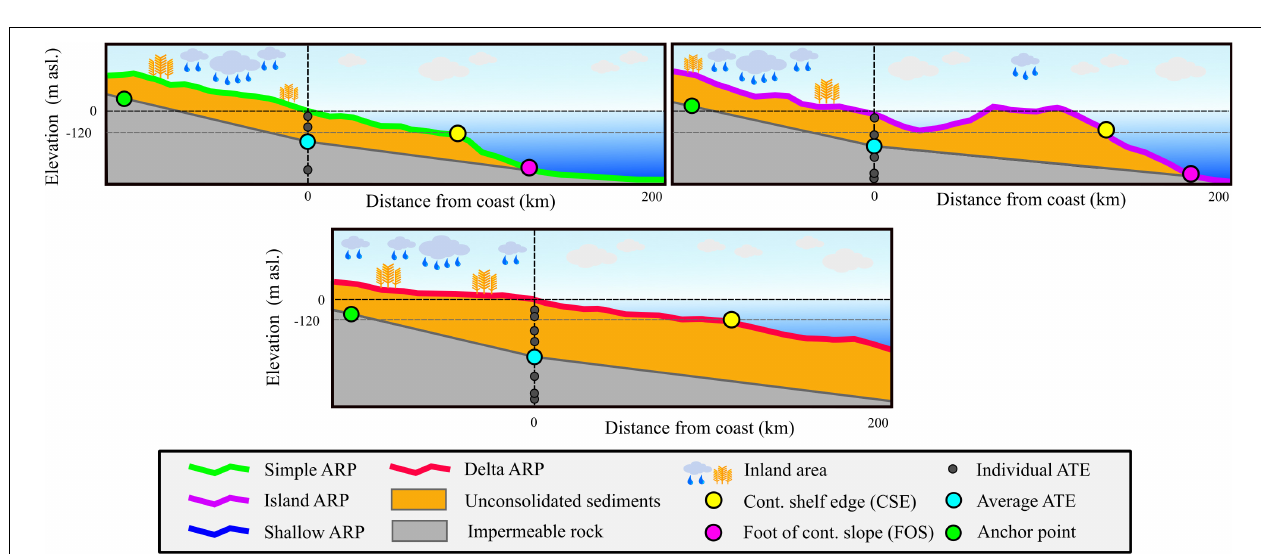
FIGURE 3 | Defining the subsurface extent of average representative profiles (ARP)s: the foot of continental slope (FOS) and the continental shelf edge (CSE) are based on Wu et al. (2017) and the average aquifer thickness estimation (ATE) is established from Zamrsky et al. (2018).